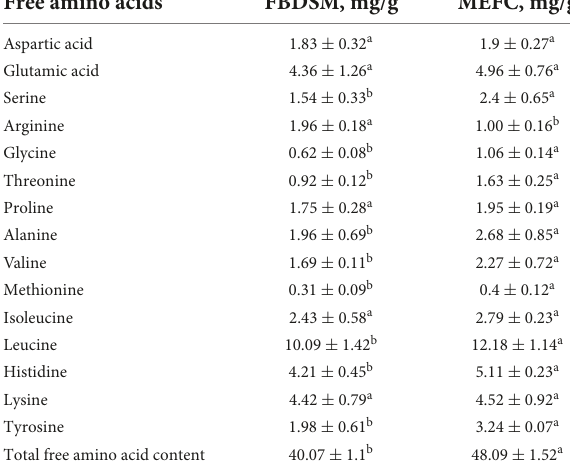
TABLE 3 Free amino acid analysis.